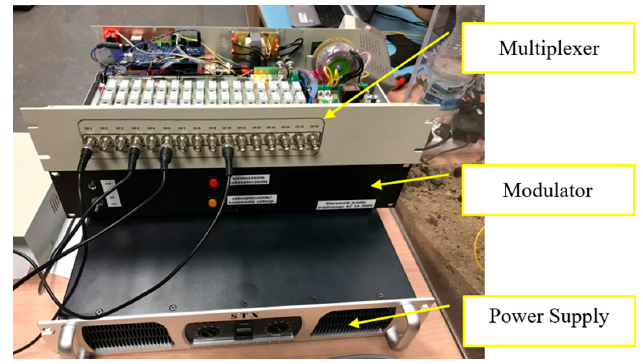
Figure 6. TERT (electrical resistance tomography) measurement system.